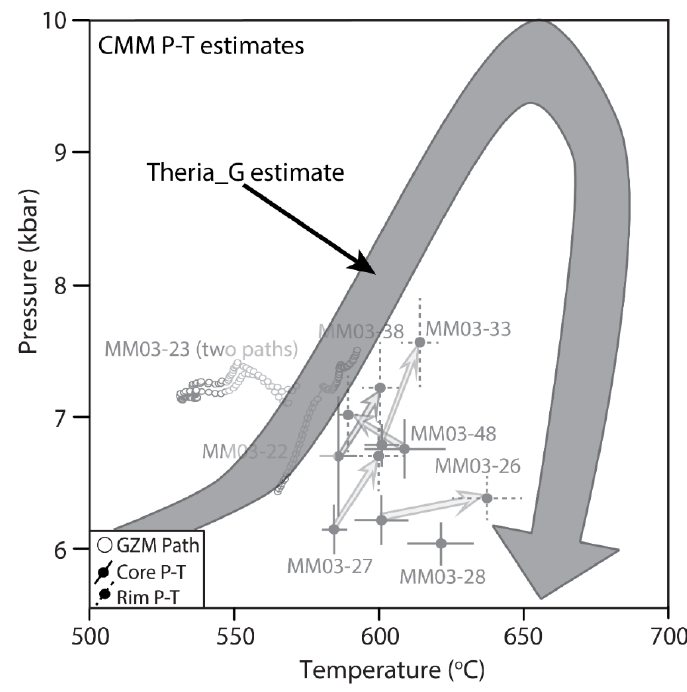
Figure 12. A simplified compilation of the most likely P-T path rocks in the Central Menderes Massif traveled along during an orogenic cycle responsible for metamorphism. This path is superimposed onto previously reported conditions [23] to demonstrate that although these recently reported conditions are not absolute, they are generally accepted as a relative estimate.